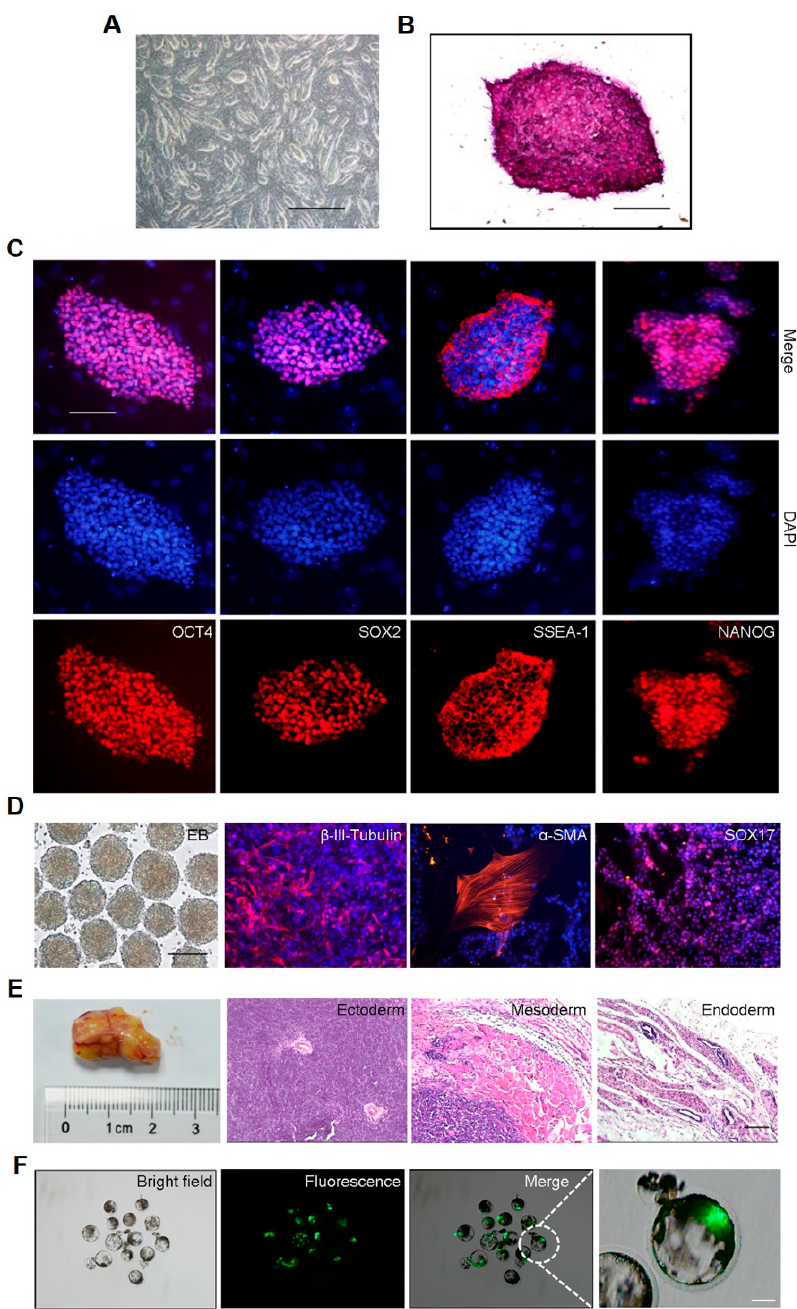
Figure 2. Pluripotency and di ff erentiation potential of LpiPSCs. ( A ) Colonies of LpiPSCs. Scale bar, 500 μ m. ( B ) AP staining of LpiPSCs. Scale bar, 100 μ m. ( C ) Immunofluorescence staining of pluripotency markers (Red) including OCT4, SOX2, SSEA-1 and NANOG. Nuclei were stained with Hoechst 333342 (Blue). Scale bar, 100 μ m; ( D ) Embryoid bodies and immunofluorescence staining of three germ layers. Nuclei were stained with Hoechst 333342 (Blue). Scale bar, 200 μ m. ( E ) Teratoma and H&E staining. Scale bar, 200 μ m; ( F ) Aggregation of LpiPSCs into inner cell mass (ICM) of porcine parthenogenetic embryos. Scale bar, 100 μ m.